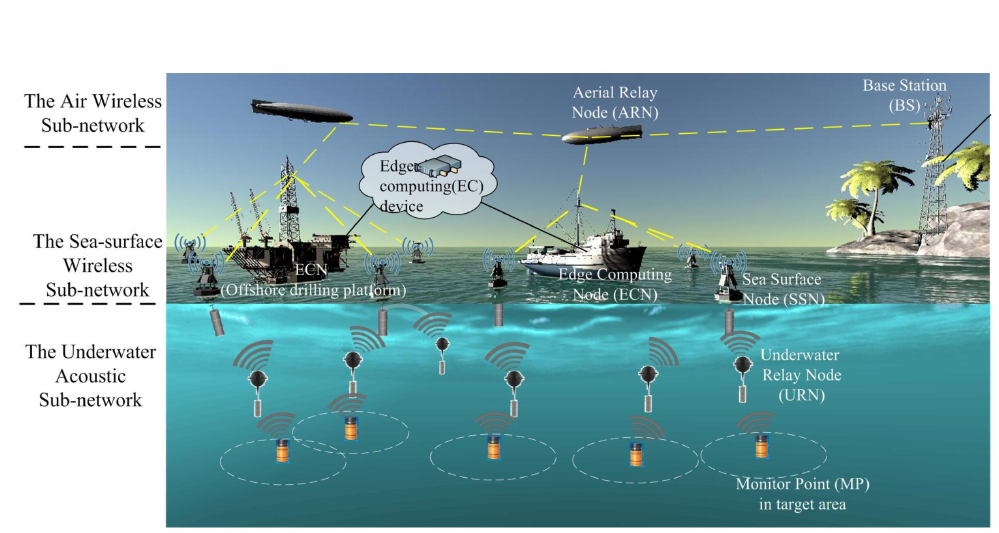
Figure 1. The HMMN-EC